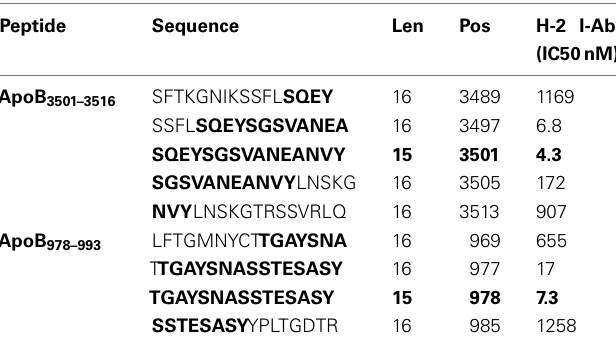
Table 2 | I-A b binding affinity ofApoB 3501–3516 andApoB 978–993 -related